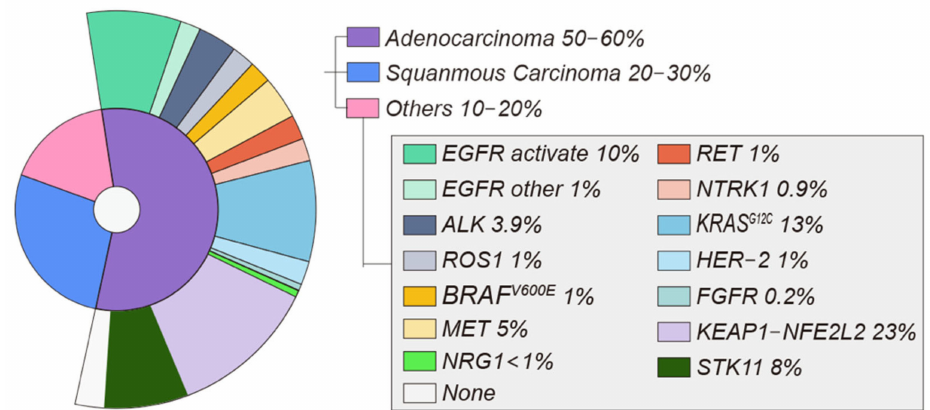
Figure 1. In total, 50–60% of NSCLC cases are adenocarcinomas, whereas 20–30% are squamous cell carcinomas. Adenocarcinoma molecular alterations related to targetable oncogenic drivers. Incidences of oncogenic driver alterations extracted from study results [6,9,10].